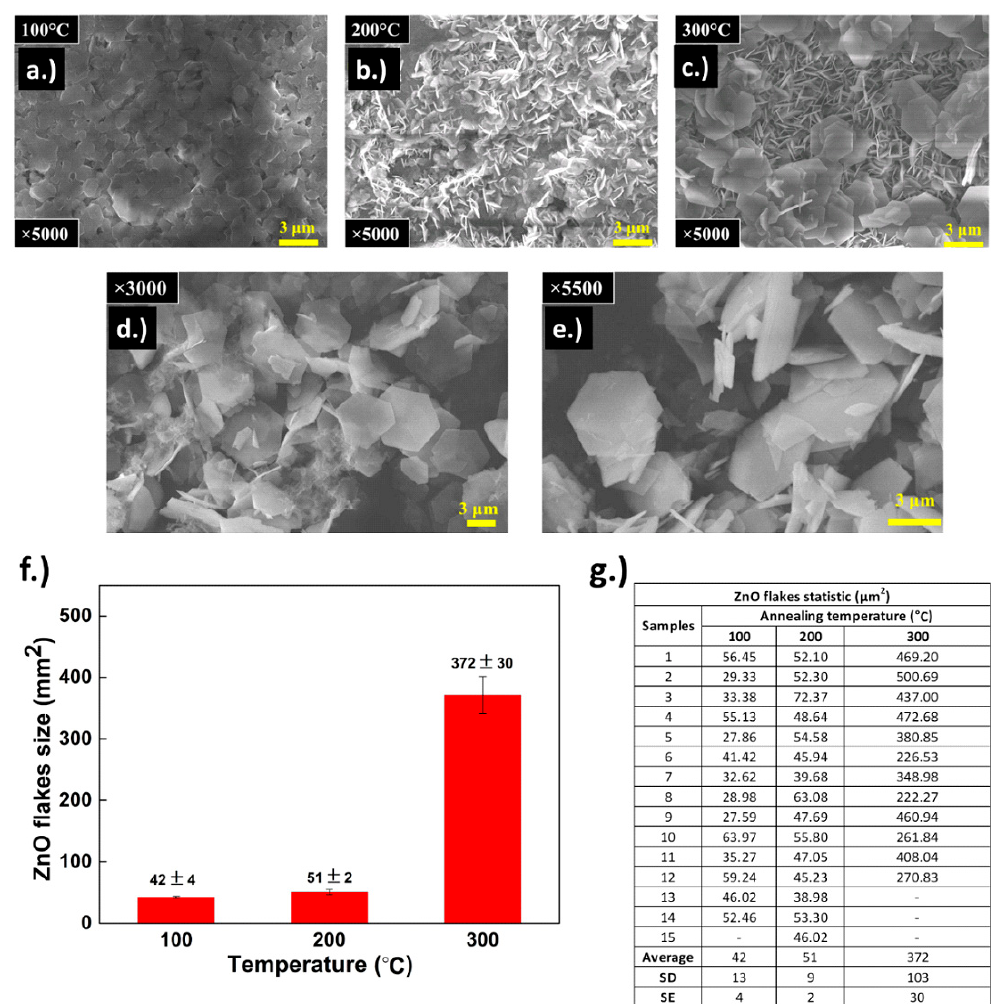
Figure 4. SEM images of the grown ZnO crystals grown for 30 min prior to annealing at ( a ) 100; ( b ) 200; and ( c ) 300 °C for 1 h; and ( d , e ) more SEM images at different magnifications and locations for flakes annealed for 300 °C for 1 h for comparison; ( f ) statistical summary of (0001) plane flake size demonstrating statistics of flakes annealed at different temperature; and ( g ) flake’s statistics at different annealing temperature (rounded down to decimal points.